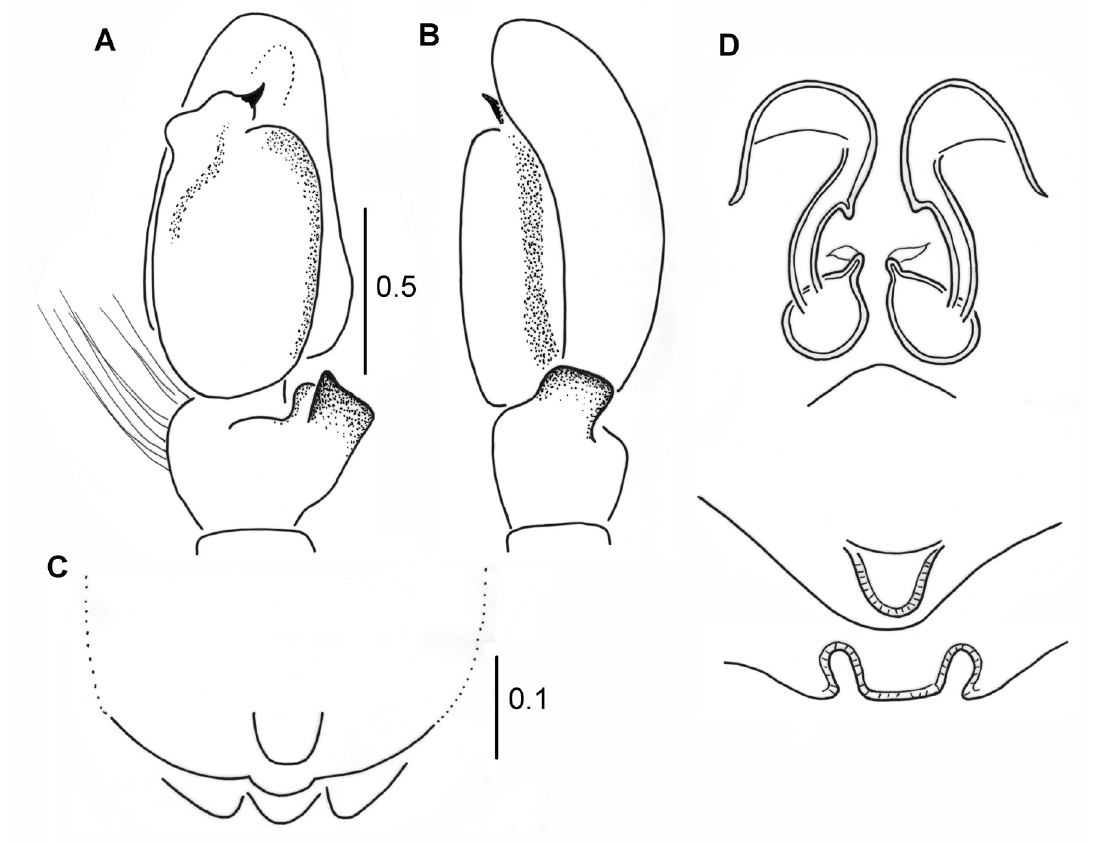
Fig. 69. Thiratoscirtus tentativus (Szűts & Jocqué, 2001), ♂♀ (MNHN). A . Palpal organ, ventral view. B . Palpal organ, lateral view. C . Epigyne. D . Internal structure of